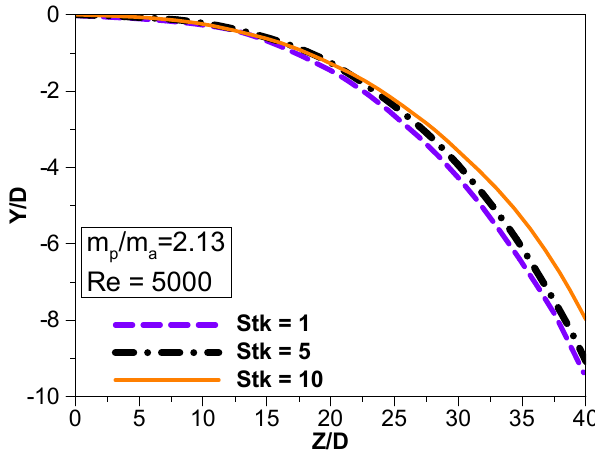
Figure 8. The e ff ect of Stokes number on the trajectory of particle-laden Figure 8. The effect of Stokes number on the trajectory of particle-laden jet.